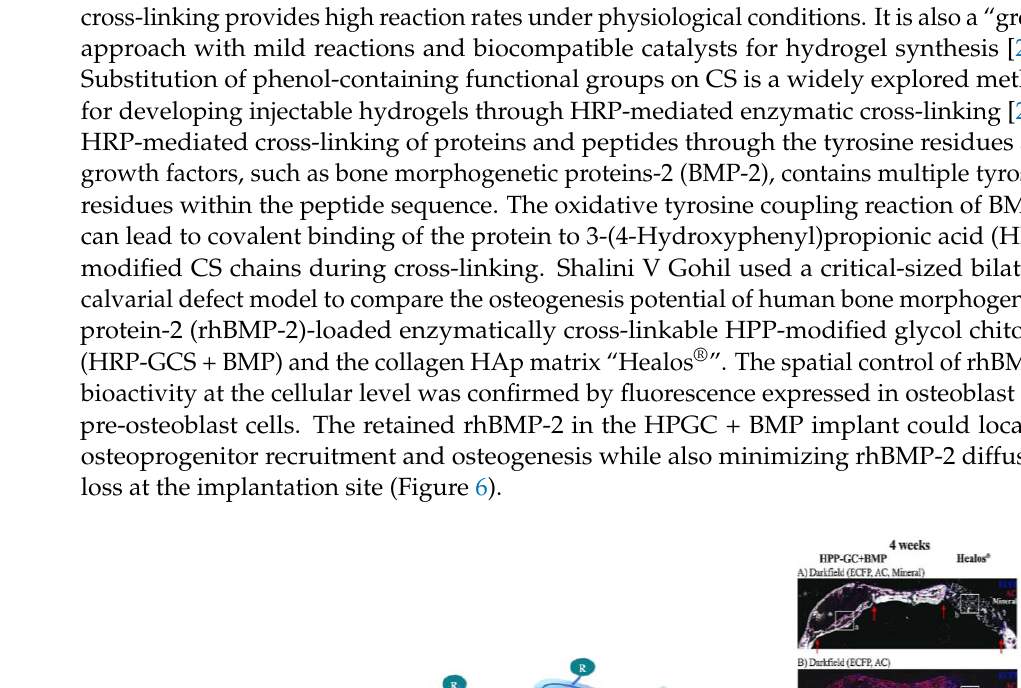
14 of 43 Figure 5. Reaction schematic and photobiology of MCS/TPVA hydrogels.